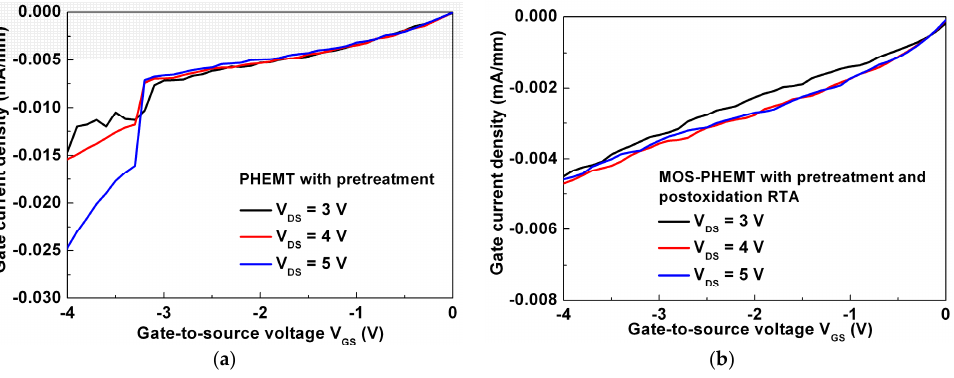
Figure 6. Gate current density versus V GS with different V DS for: ( a ) referenced PHEMT; and ( b ) MOS- PHEMT.